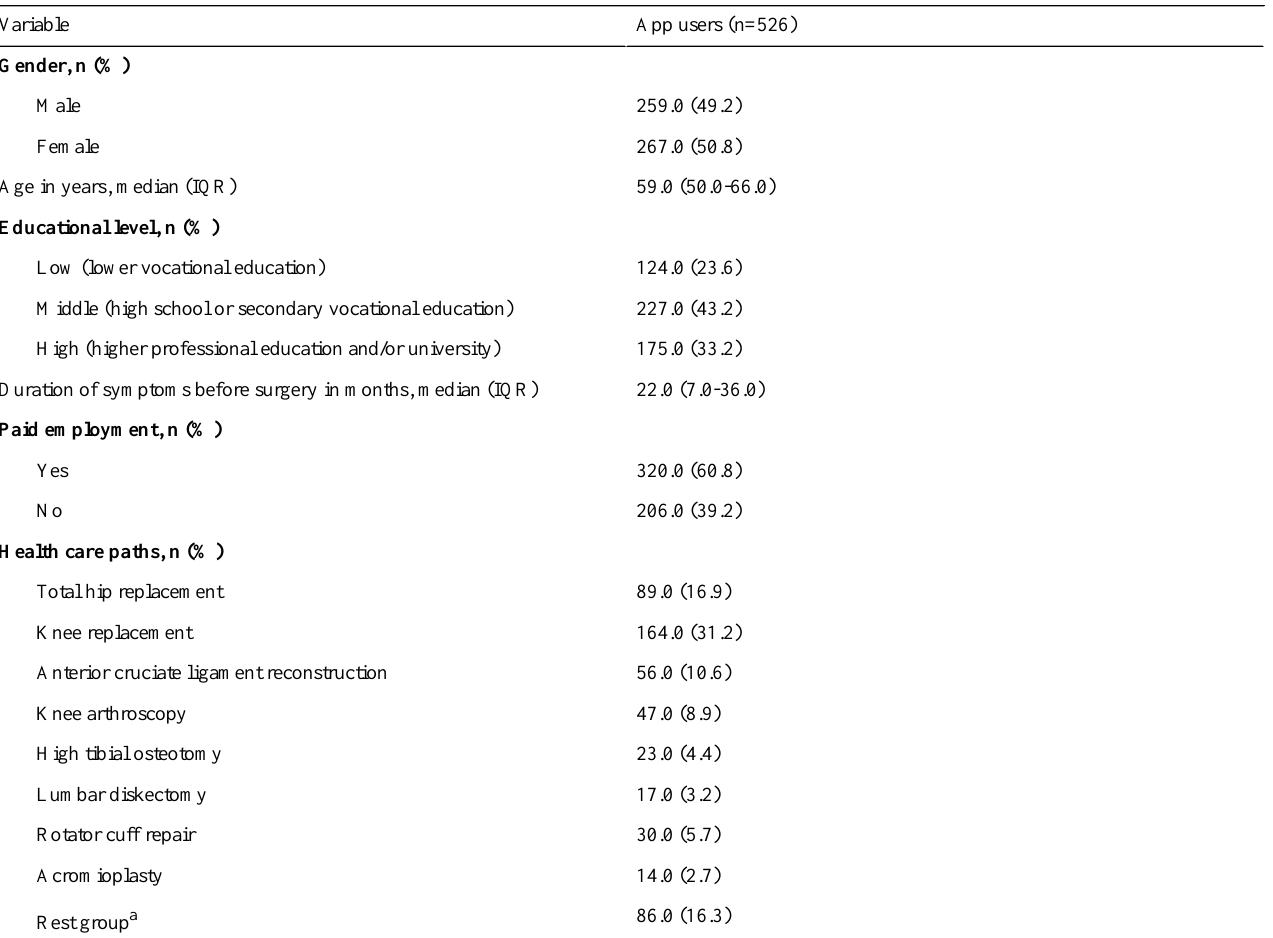
Table 1. Patient characteristics of app users.